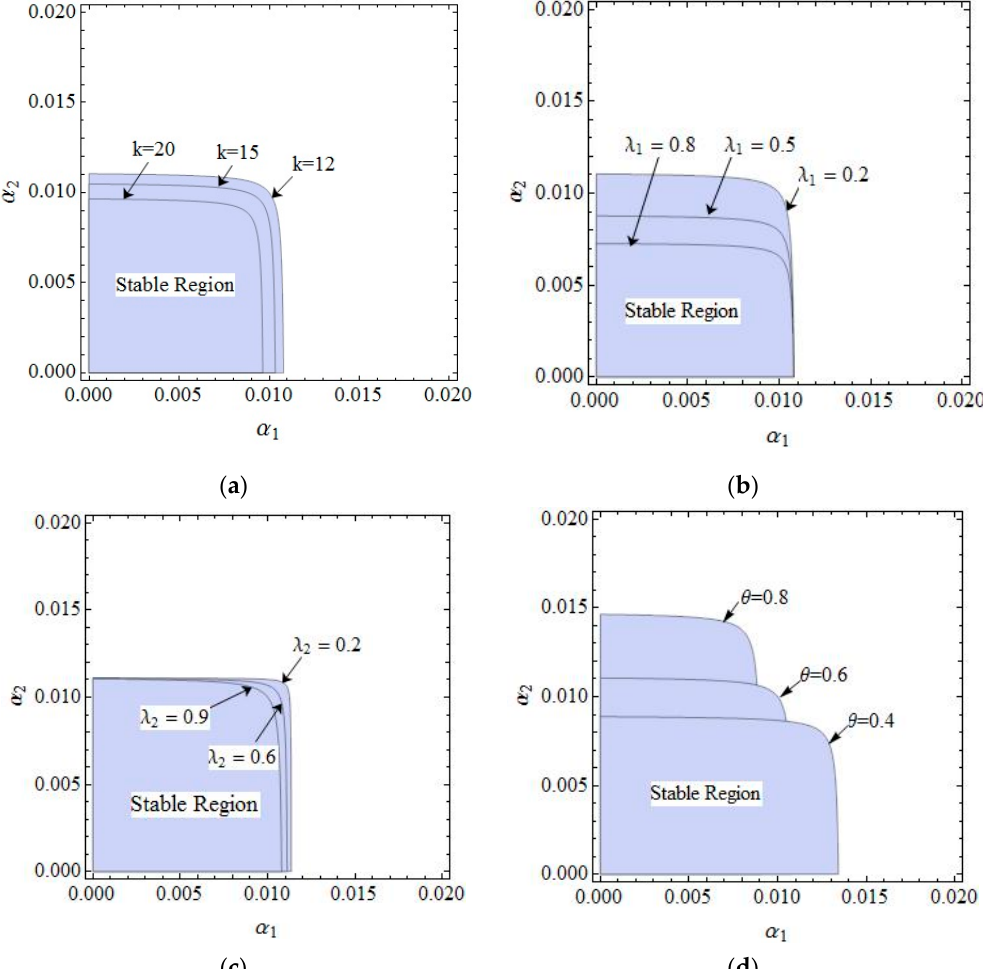
Figure 4. The stability regions in the phase plane of ( α 1 , α 2 ) with di ff erent parameter values. ( a ) The stable region with k changing, ( b ) The stable region with λ 1 changing, ( c ) The stable region with λ 2 changing, ( d ) The stable region with θ changing.